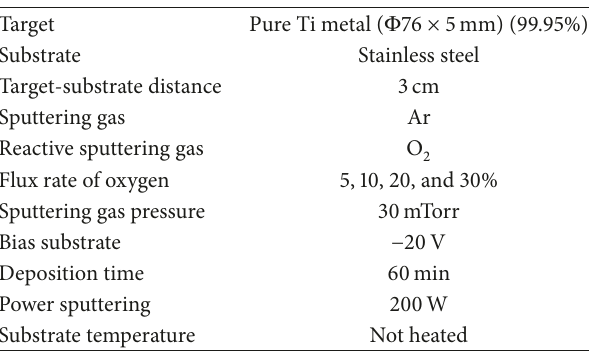
Table 1: Sputtering conditions for the deposition of TiO 2 coatings.